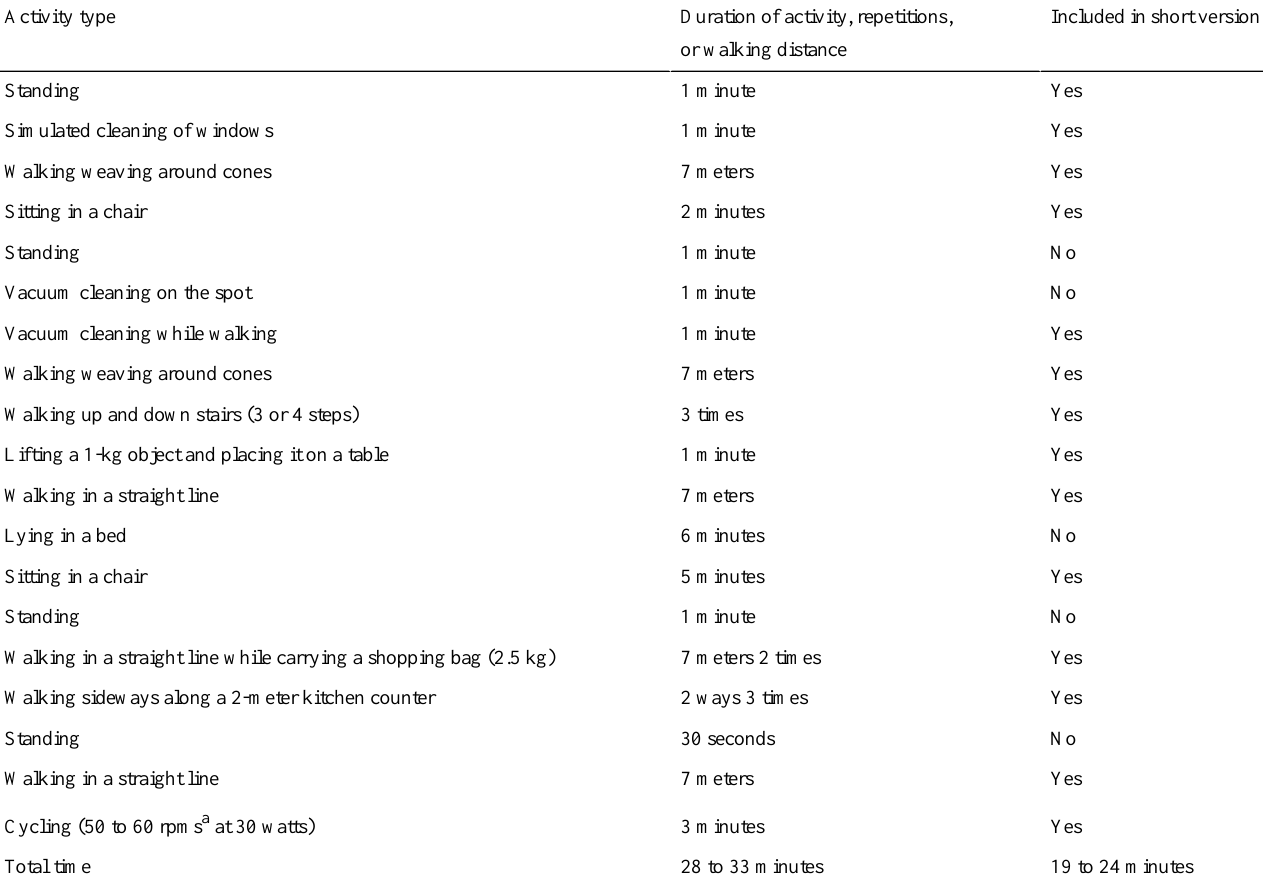
Table 2. The developed activity protocol based on principles and free living tasks from other protocols.